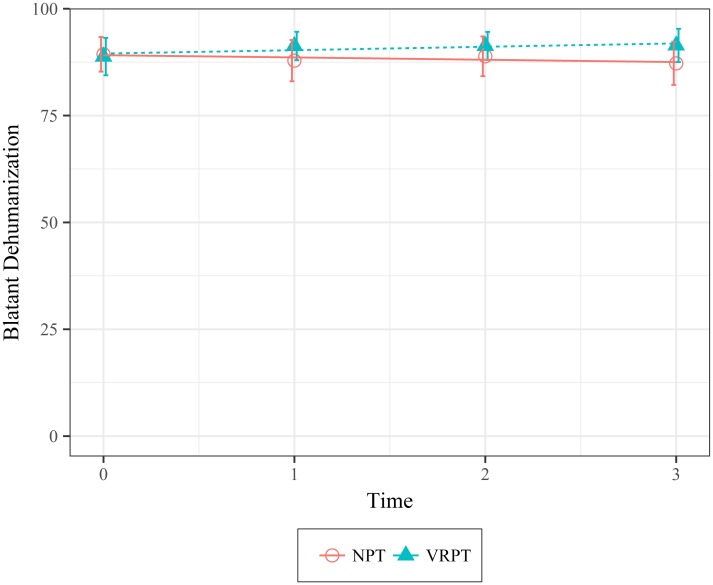
Mean values of blatant dehumanization of the homeless as a function of condition over time.Error bars represent 95% Confidence Intervals.